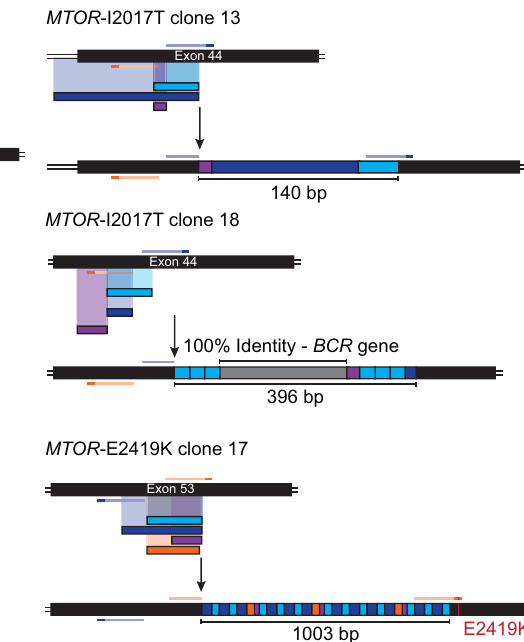
after co-selection. TOPO cloning and Sanger sequencing were performed to char- acterizethe largeinsertions.ThepegRNAand itsPAMsequencearerepresentedin orange and dark orange, respectively. The nick sgRNA and its PAM sequence are representedinblueanddarkblue,respectively. b Sameasin a forlargeinsertionsat MTOR exon 53 from single cell-derived K562 clones harboring the MTOR -E2419K hyperactivating